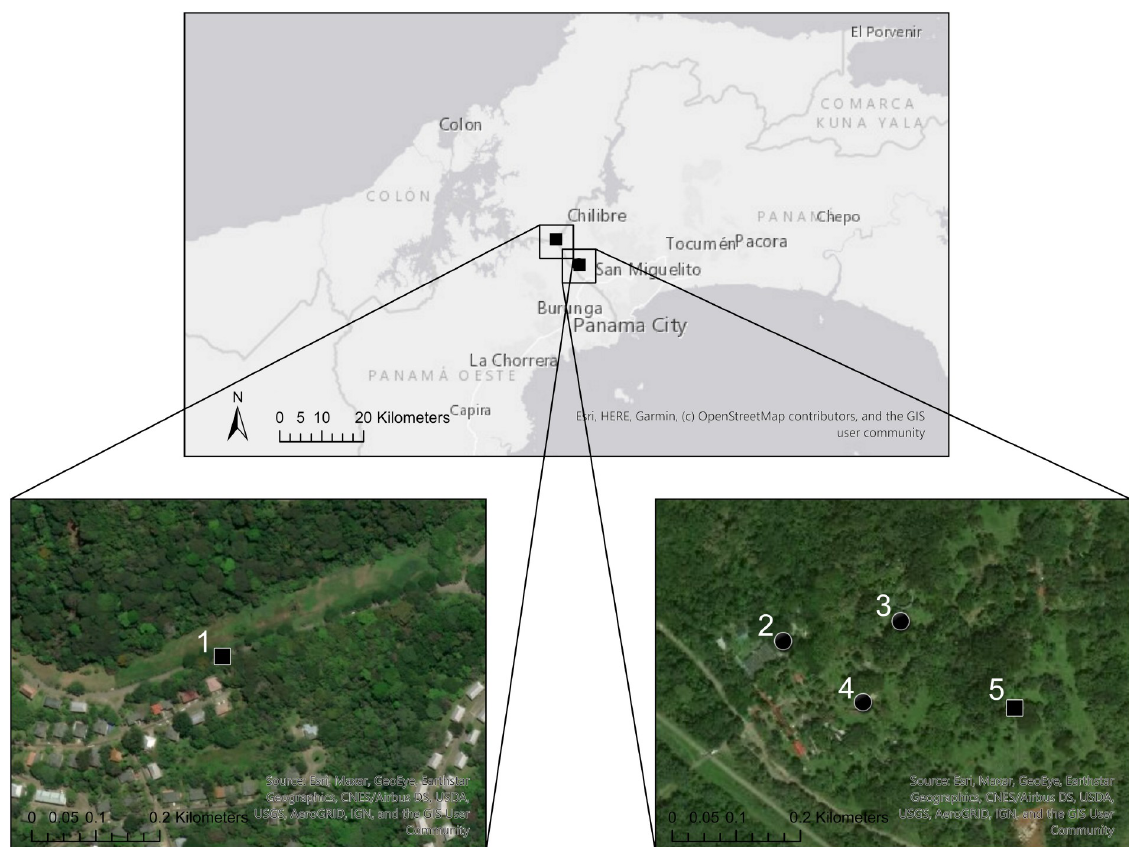
Fig 1. Mapping Ornithodoros puertoricensis collection sites. Tick collection efforts were centered in two primary locations (upper insert). The two expanded bottom panels show five sites where collection efforts took place. At sites one and five (squares), either zero ticks were obtained or there were insufficient numbers to test. At sites two through four (circles), ticks were collected. A scale is shown in kilometers in the lower left panels. Information for a given site number is further detailed in Table 2. The greyscale basemap was created using https:// services.arcgisonline.com/ArcGIS/rest/services/Canvas/World_Light_Gray_Reference/MapServer, and the imagery basemap was created using